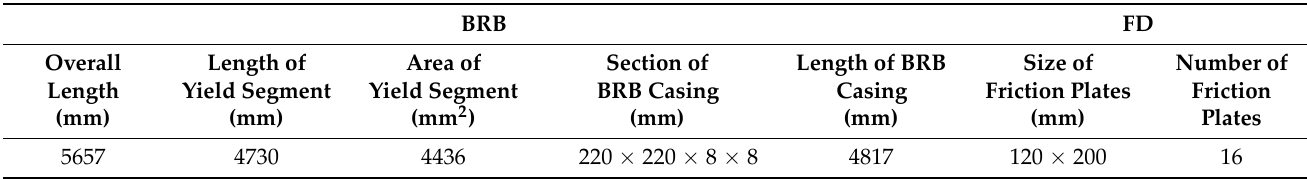
Table 5. Construction details of the FBRB.